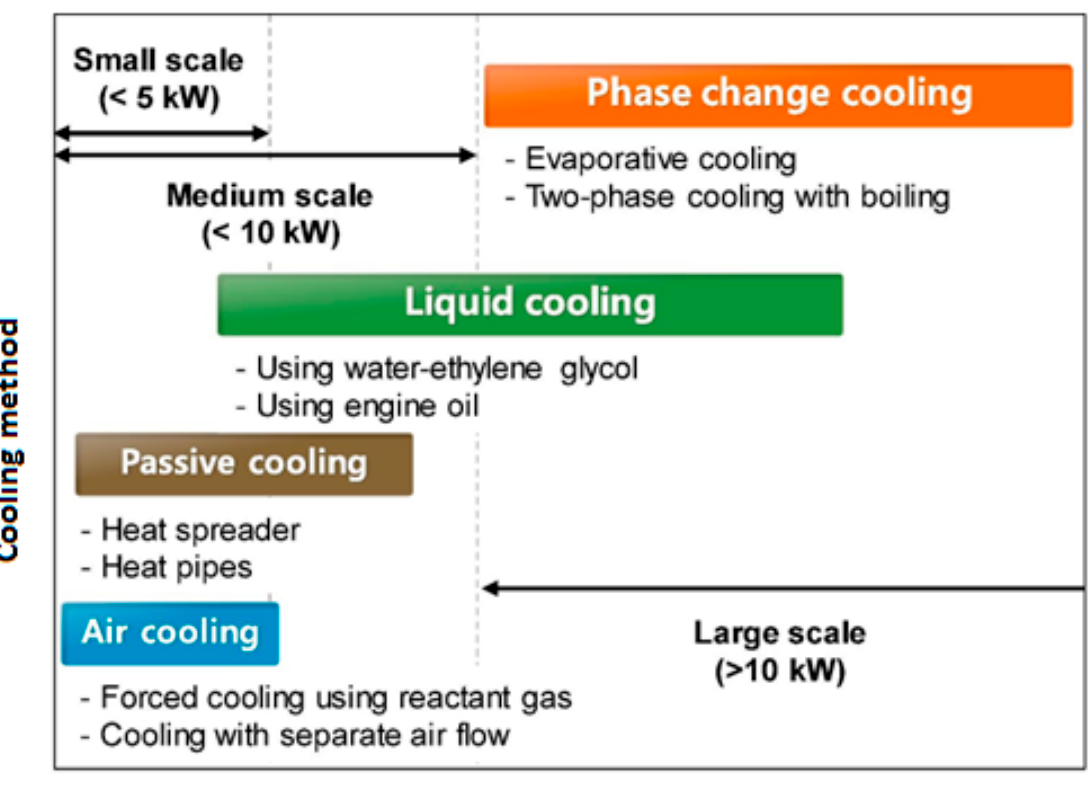
Figure 49. Different cooling techniques, adapted with permission from Ref. [157]. Copyright © 2019 Elsevier